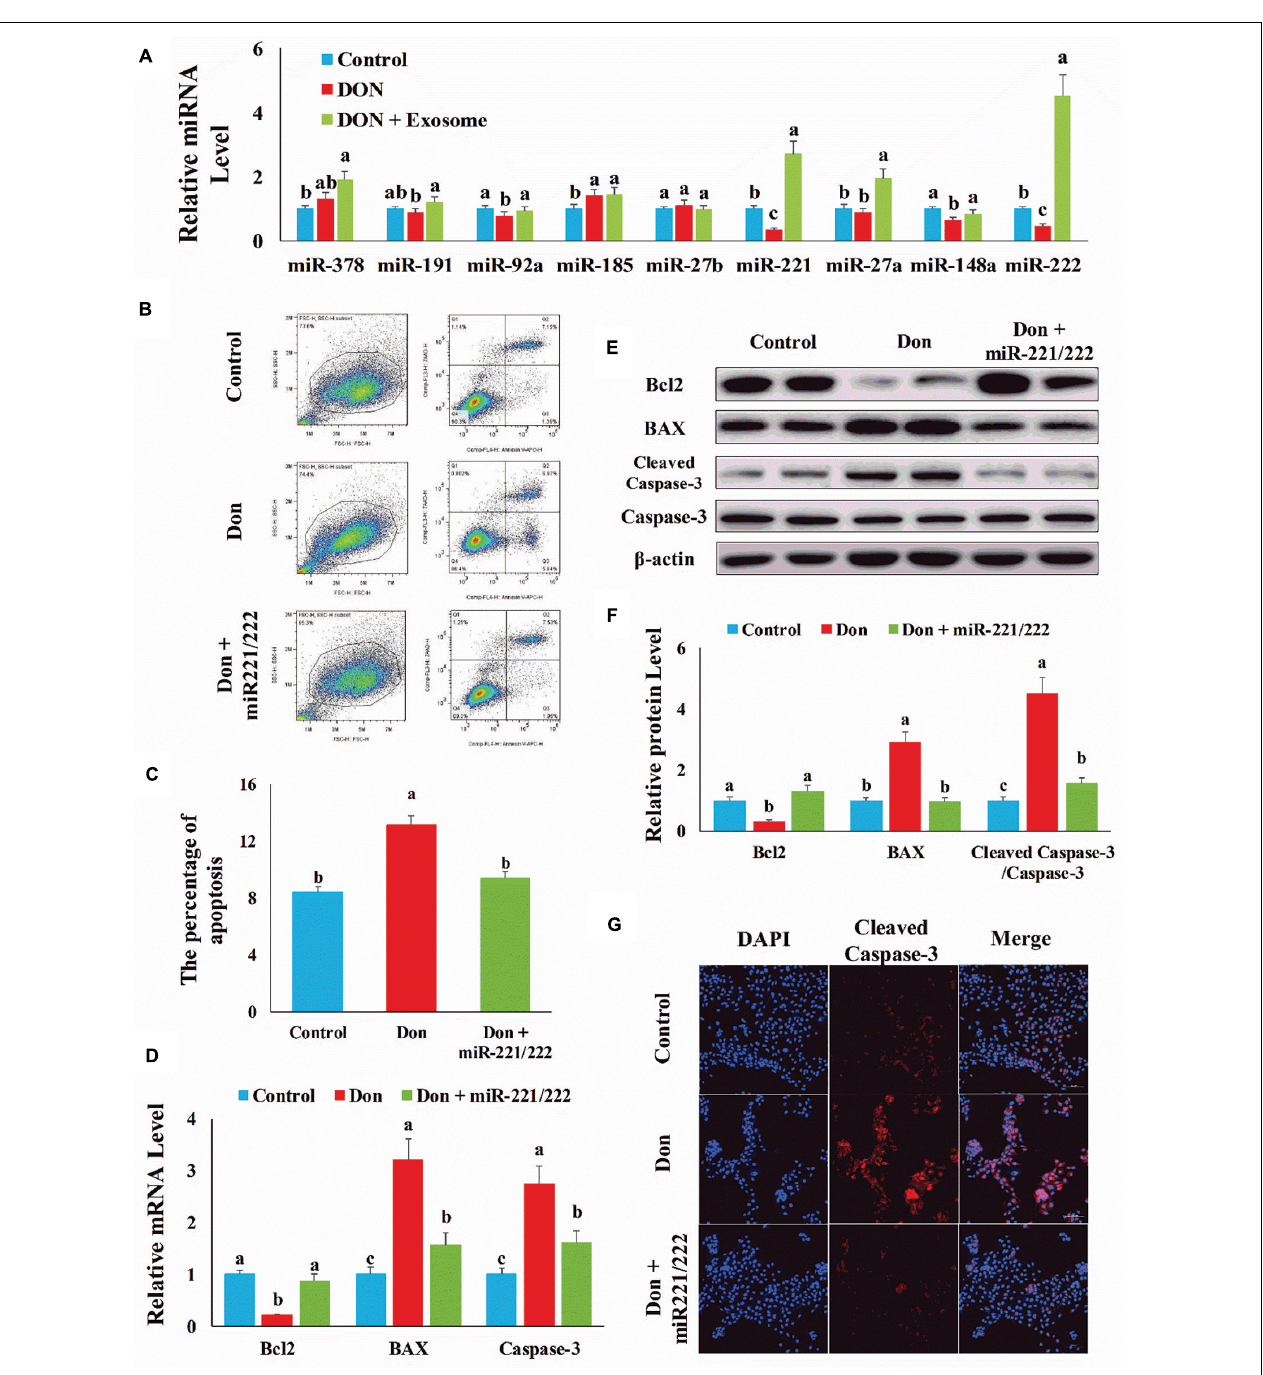
FIGURE 3 | MiR-221/222 attenuated Don-induced intestinal epithelial cell apoptosis. (A) qPCR was used to examine the miRNA, highly expressed in exosome and related to apoptosis and proliferation, levels in intestinal epithelial cells. (B) Representative images of apoptosis assay for intestinal epithelial cells by using the apoptosis detection kit. Cells localized in Q4 displayed Annexin V-APC-negative/7AAD-negative viable cells. The cells gated in Q2 and Q3 quadrant displayed Annexin V-APC-positive apoptotic cells. (C) The quantitative result of (A) . (D) qPCR results indicated that exosome attenuated Don-induced intestinal epithelial cell apoptosis. (E) Western blot results showed exosome attenuated Don-induced intestinal epithelial cell apoptosis. (F) The relative protein levels obtained by WB band gray scanning. (G) Representative images of the caspase-3 immunofluorescent staining for apoptotic intestinal epithelial cells. Cleaved caspase-3: red, a molecular marker of apoptosis; DAPI: blue, cell nucleus; Merge: the apoptotic cells. Our results were presented as mean ± SEM of triplicate independent experiments for each group. Bars with different letters indicate they are significantly different ( p < 0.05). In (G) , magnification = × 100; the scale bar on the photomicrographs represents 100 µ m. Don, IPEC-J2 cells were exposed to 1.6 µ g/ml Don for 12 h. Don + miR-221/222, IPEC-J2 cells were transfected with 80 nM miR-221/222 mimics for 24 h, then exposed to 1.6 µ g/ml Don for 12 h.